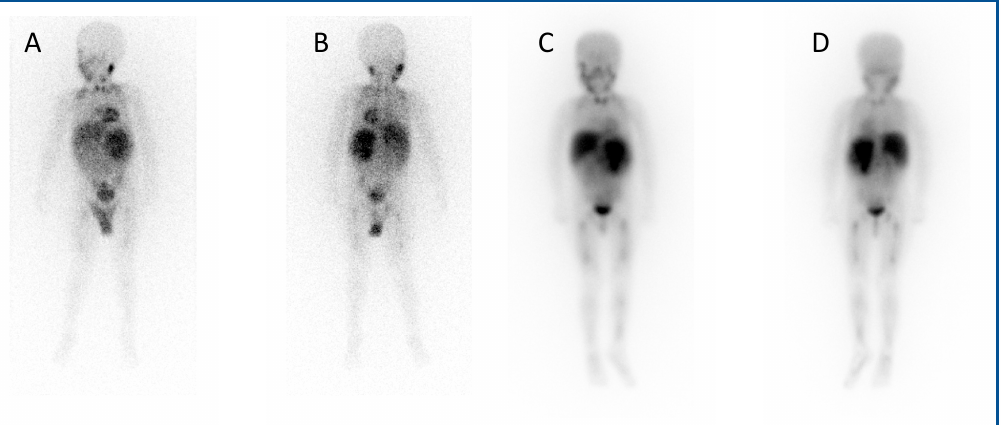
Figure 1. An example of a theragnostic pairing of radiopharmaceuticals in a child with metastatic neuroblastoma. Diagnostic 123 I-mIBG imaging ( A ) anterior and ( B ) posterior views of whole-body planar scintigraphy demonstrating pathological uptake in a large left sided retroperitoneal mass as well as in metastatic disease in the femora and jaw, as well as physiological uptake in the salivary glands, heart, liver, urinary bladder and (despite blockade) in the thyroid gland. Corresponding ( C ) anterior and ( D ) posterior images following 131 I-mIBG therapy administration showing uptake of the agent in the tumour and metastases as well as in physiological